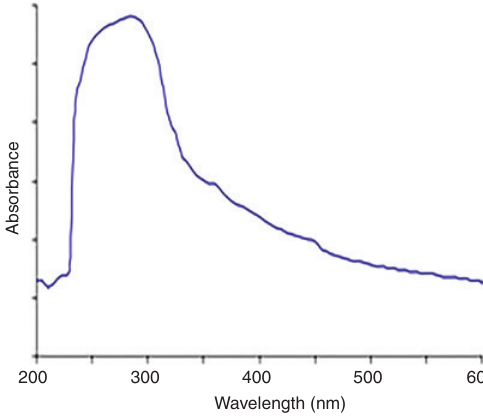
Figure 7: UV-Vis spectrum of PbS nanostructures.